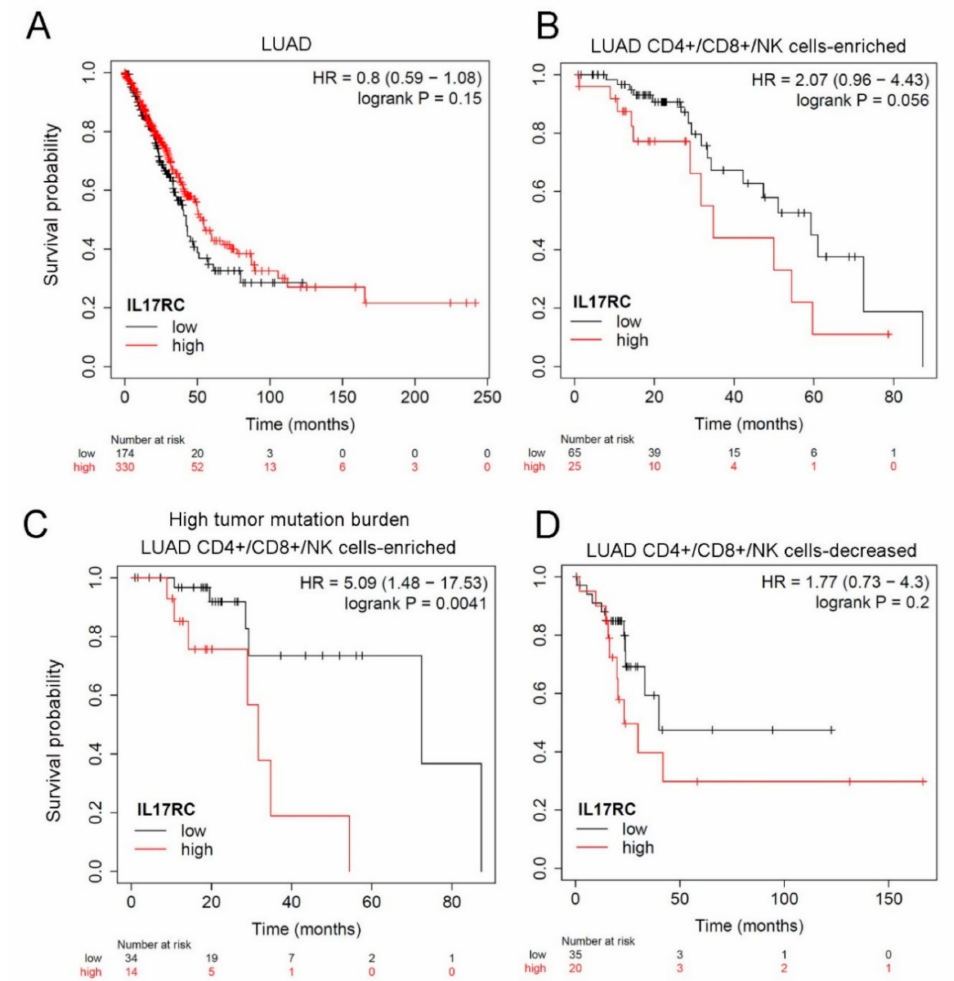
Figure 3. Prognostic value of the expression of interleukin 17 receptor C (IL-17RC) in patients with lung adenocarcinoma (LUAD) stratified by immune cell infiltration and tumor mutation burden statuses. Kaplan-Meier overall survival curves are plotted based on ( A ) all LUAD patients ( n = 504), ( B ) cluster of differentiation 4-positive (CD4+)/CD8+/natural killer (NK) cell-enriched LUAD pa- tients ( n = 90), ( C ) CD4+/CD8+/NK cell-enriched LUAD patients with a high tumor mutation burden ( n = 48), and ( D ) CD4+/CD8+/NK cell-decreased LUAD patients ( n =